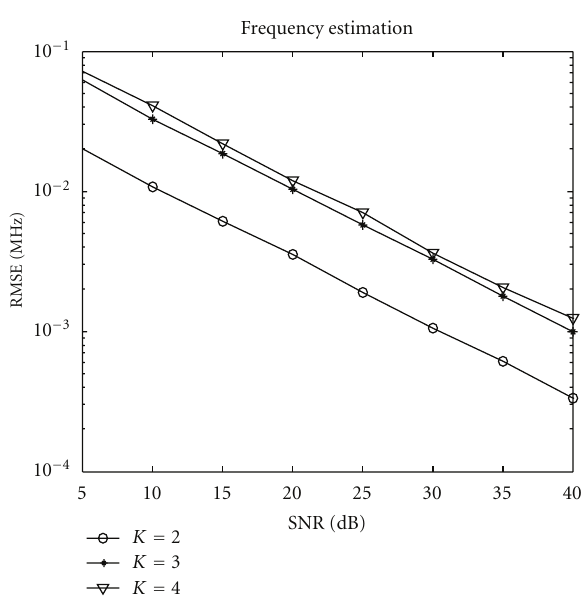
Figure 10: Frequency estimation with di ff erent